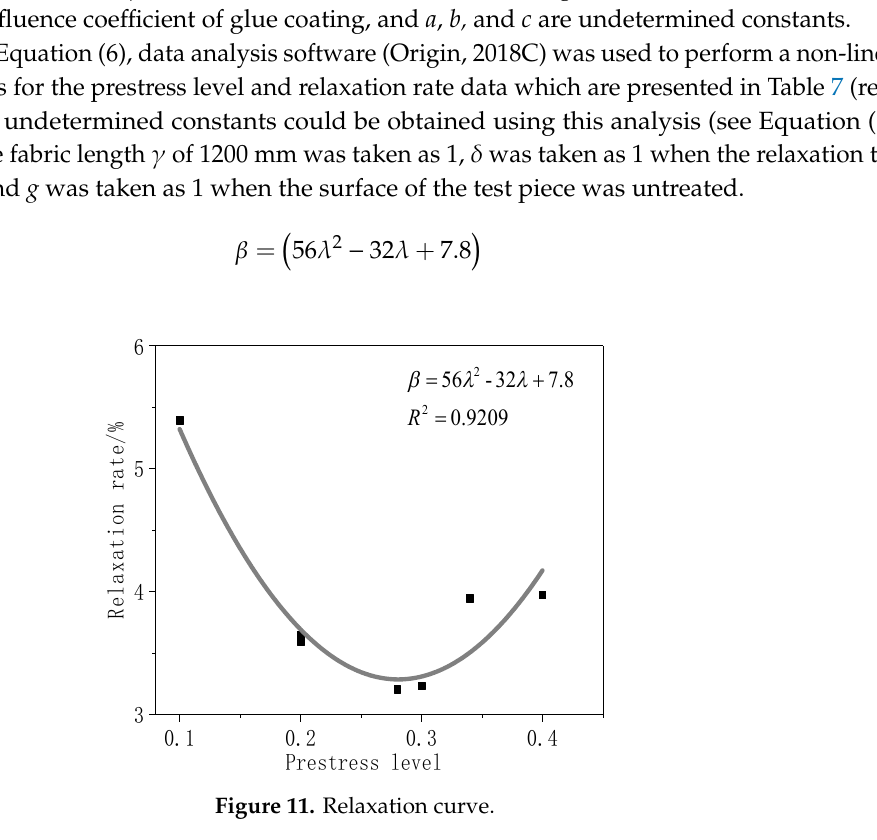
Table 8. Comparison of relaxation test values and calculation values.